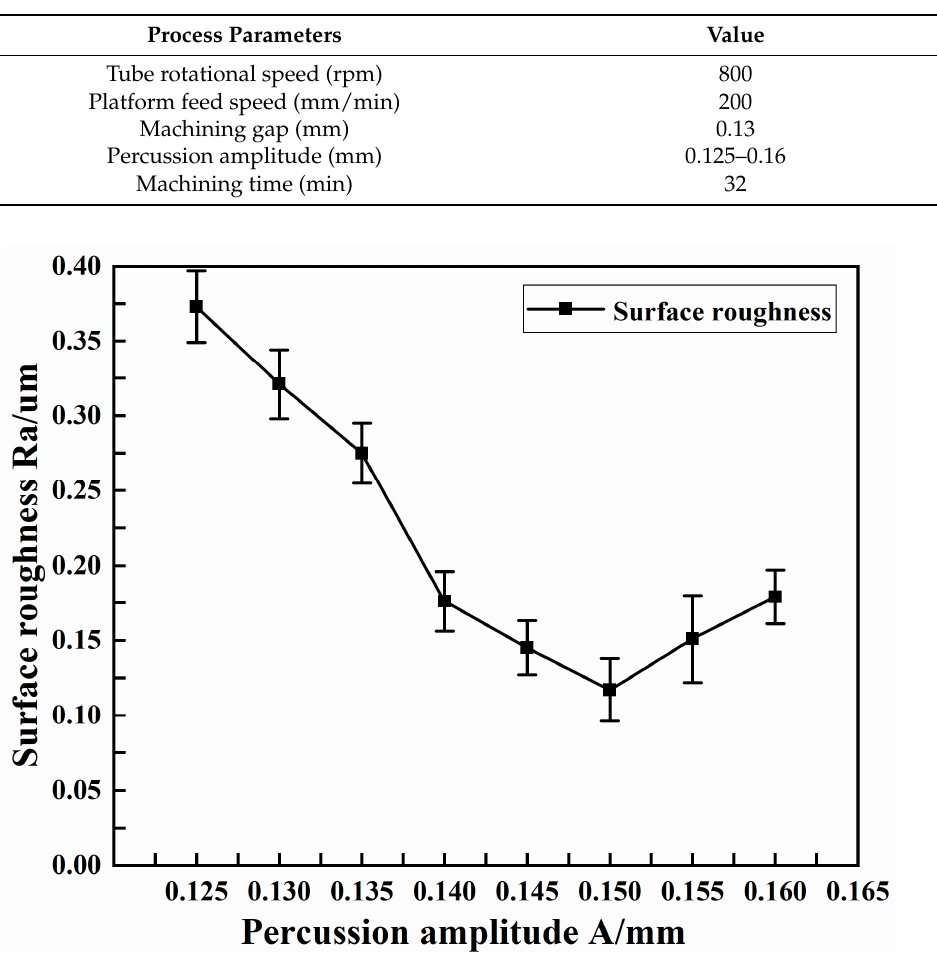
Table 7. Experimental conditions selected for different percussion amplitudes.